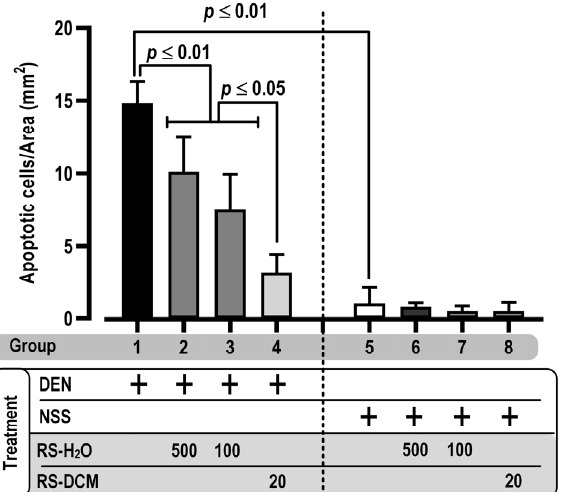
Figure 5. The e ff ect of RS on apoptotic cell expression as indicated using TUNEL assay . The values Figure 5. The effect of RS on apoptotic cell expression as indicated using TUNEL assay. The values are expressed as mean ± SD . The data display non - normal distribution ( Shapiro – Wilk : p ≤ 0 . 05 ) and are expressed as mean ± SD. The data display non-normal distribution (Shapiro–Wilk: p ≤ 0.05) and were analyzed for statistical signi fi cance using the non - parametric Mann – Whitney U test . RS dosage were analyzed for statistical significance using the non-parametric Mann–Whitney U test. RS dosage unit is mg / kg BW . unit is mg/kg